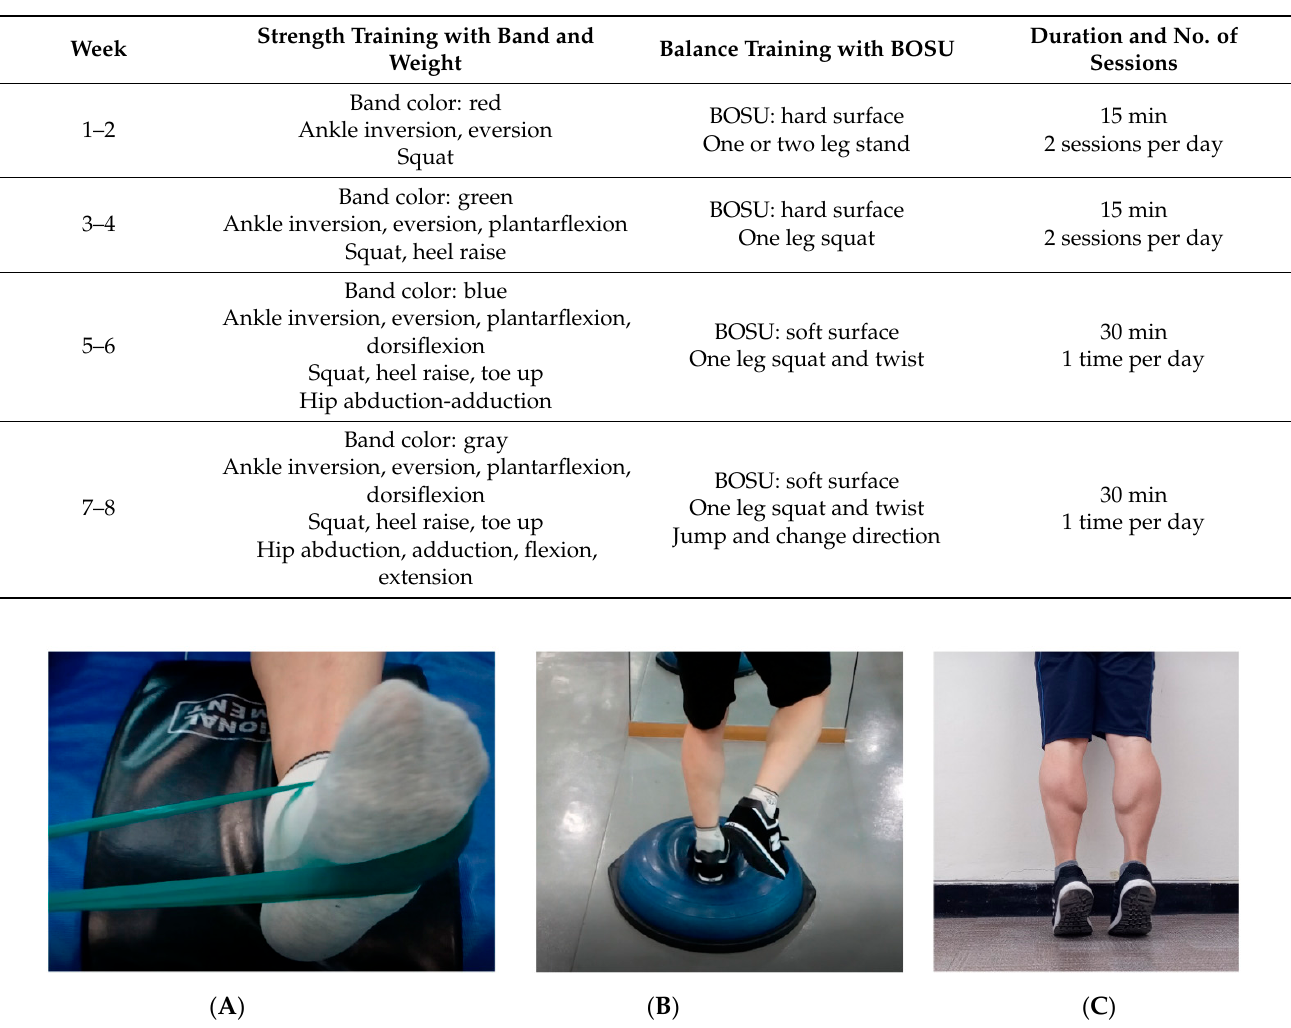
Table 1. Outline of rehabilitation program.